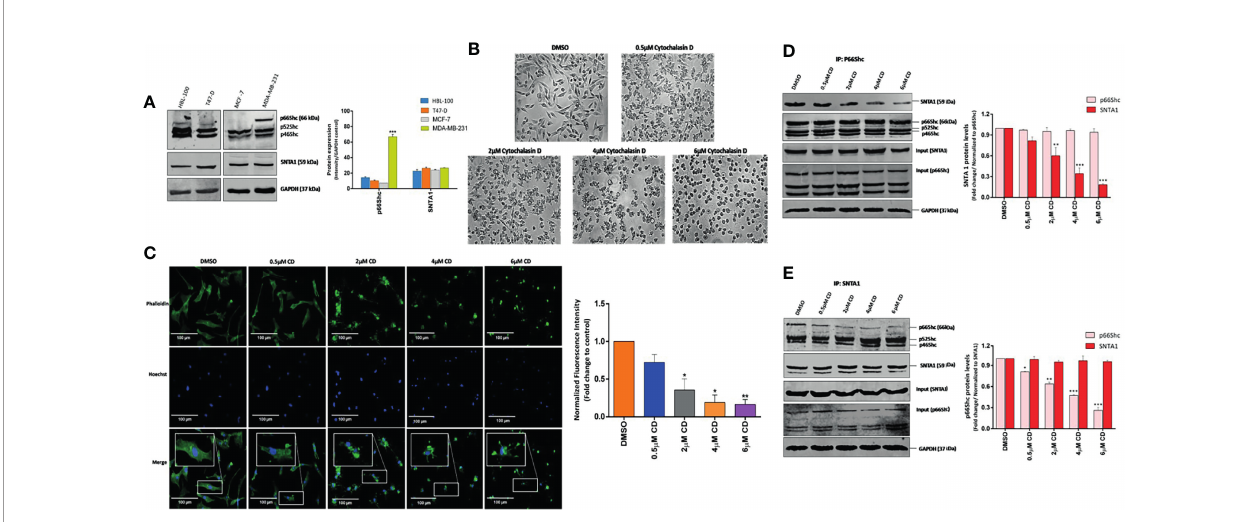
FIGURE 1 | Cytochalasin D mediated actin depolymerization modulates SNTA1/p66Shc interaction in MDA-MB-231 cells. (A) Western blot analysis showing endogenous protein expression of p66Shc and SNTA1 in HBL-100, T47-D, MCF-7 and MDA-MB-231 breast cancer cell lines. Anti-GAPDH was used as loading control. The bar graphs show the relative protein expression levels of p66Shc and SNTA1 in HBL-100, T47-D, MCF-7 and MDA-MB-231 breast cancer cells. (B) Representative photomicrographs showing the effect Cytochalasin D treatment on morphology of MDA-MB-231 cells. Cytochalasin D (0.5 µM, 2 µM, 4 µM, 6 µM) was added to MDA-MB-231 cells for 6 hours and the morphological characteristics were analyzed by phase contrast microscopy. DMSO was used as vehicle control. Cytochalasin D treated cells adopted sphere-like cell morphology in comparison to normal spindle shaped morphology of control cells. (C) Representative fl uorescent photomicrographs showing effect of cytochalasin D treatment on F-actin actin organization. Cytochalasin D (0.5 µM, 2 µM, 4 µM, 6 µM) was added to MDA-MB-231 cells for 6 hours and actin cytoskeletal organizations were analyzed by phalloidin-Alexa Fluor 488 staining. Control cells showed uniform F-actin distribution while as cytochalasin D treated cells displayed irregular and punctate F-actin organization. The bar graphs show the fold change in fl uorescent intensity of phalloidin stained F-actin in cytochalasin D treated cells in comparison to control. (D, E) Endogenous p66Shc and SNTA1 were immunoprecipitated from lysates obtained from cells pretreated with cytochalasin D (0.5 µM, 2 µM, 4 µM, 6 µM) for 6 hours and the protein levels of associated SNTA1 and p66Shc were analyzed by Western blotting respectively. DMSO was used as vehicle control. The densitometric bar graphs of western blots show the fold change in SNTA1 and p66Shc protein levels in p66Shc and SNTA1 immunoprecipitated protein complex respectively. Results shown were repeated three times and are expressed as mean ± SD fold change over control level set to 1 unit and normalized to total protein. The statistical analysis was done using two-way ANOVA followed by Sidak`s multiple comparison test to determine level of signi fi cance. *P < 0.05; **P < 0.01; ***P <